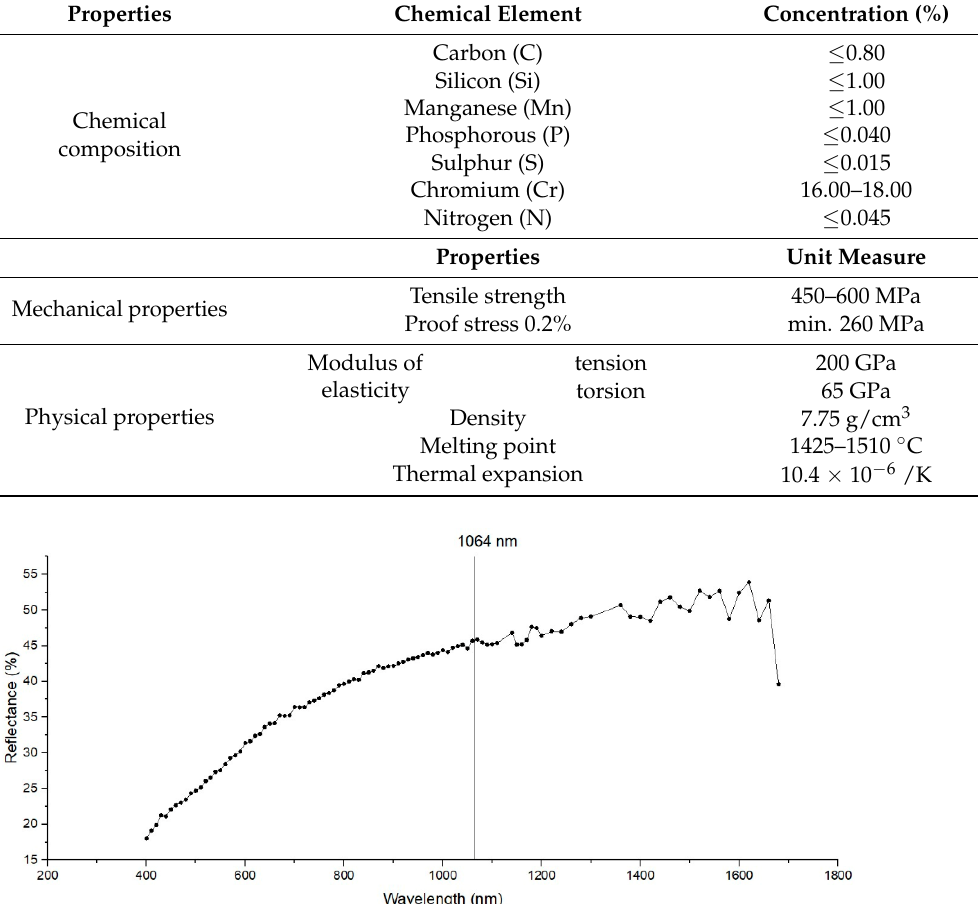
Figure 1. Spectral reflectance of the sample of AISI 430 stainless steel ferritic.